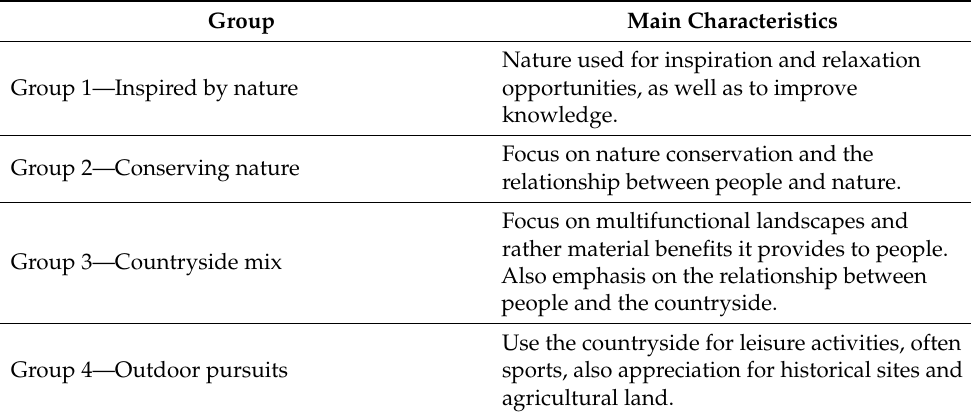
Table 3. Main characteristics of the four groups of